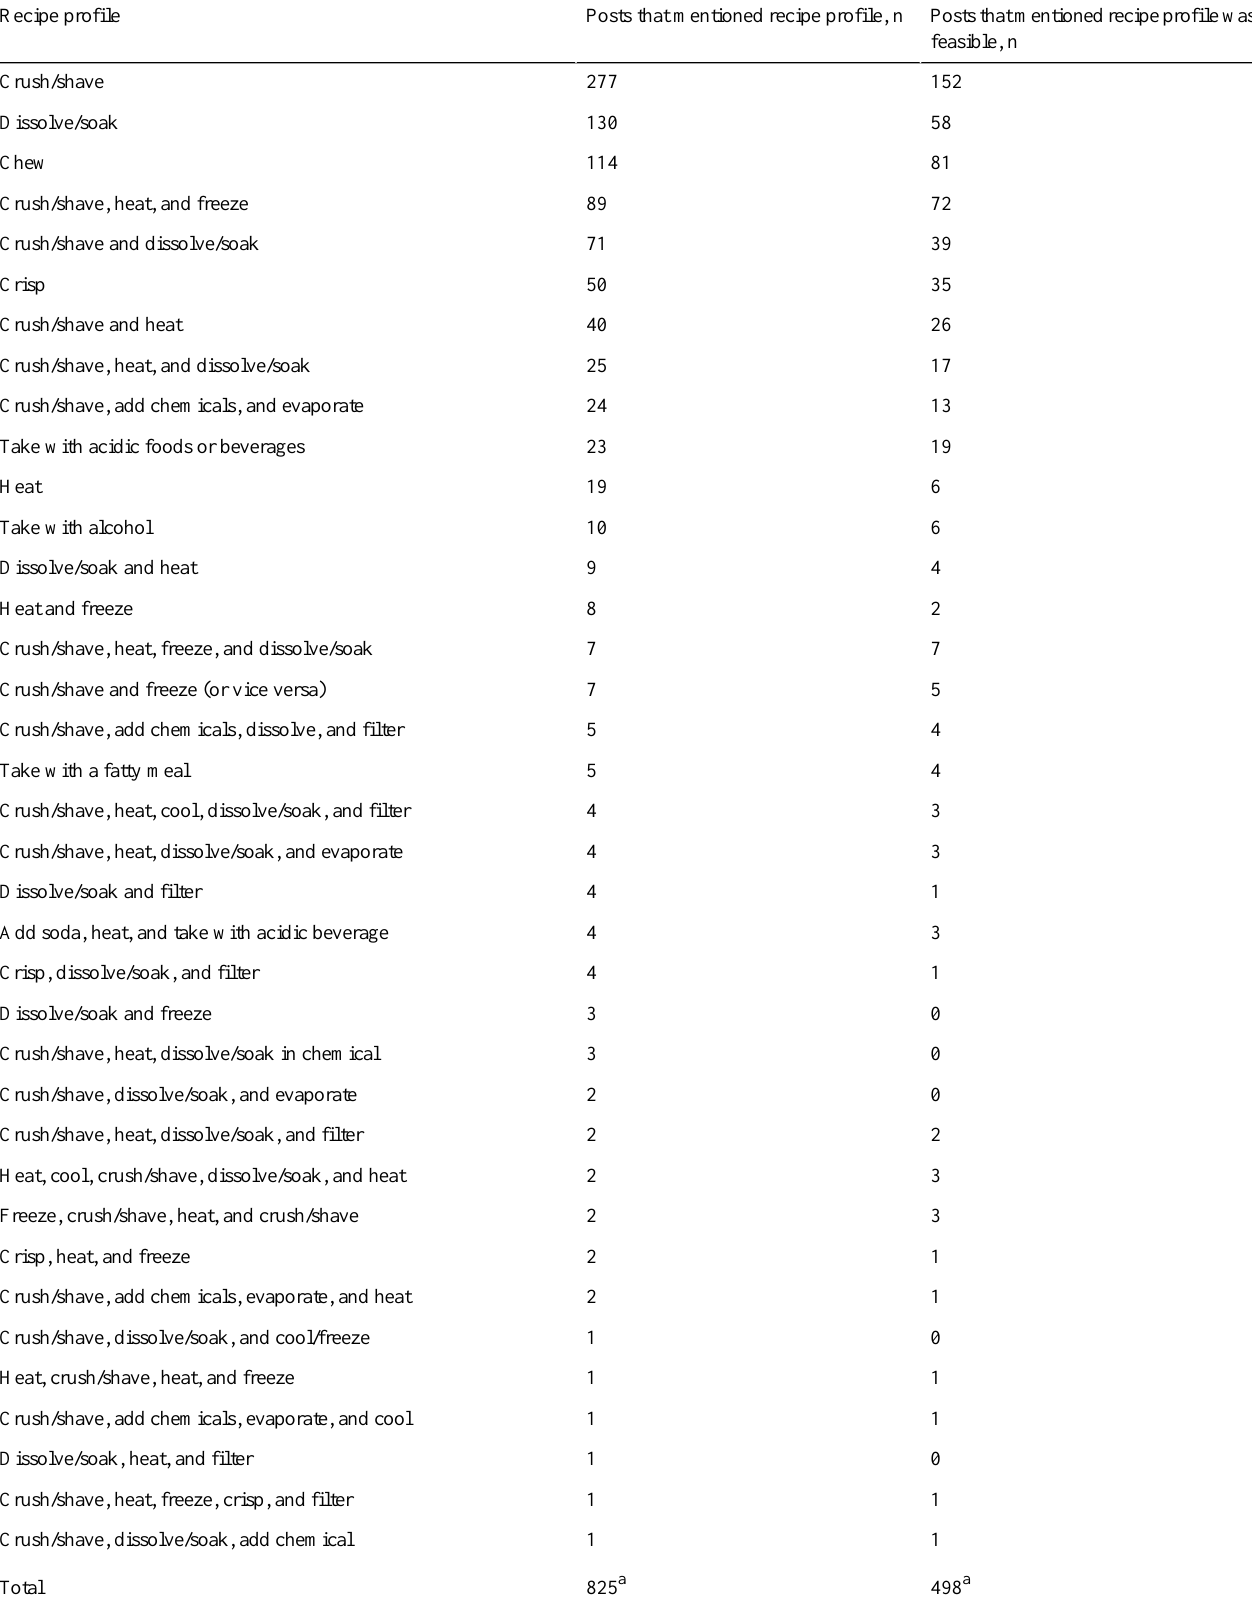
Table 4. Frequency of reformulated OxyContin recipe profiles.